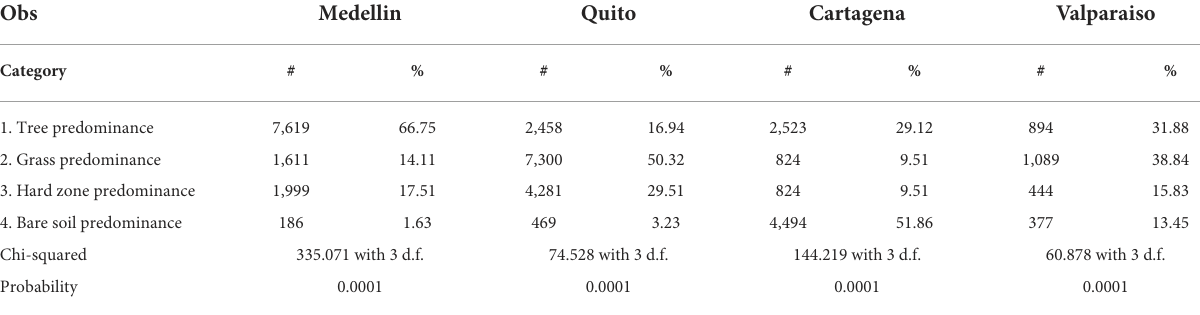
TABLE 3 Kruskal–Wallis H test for the four